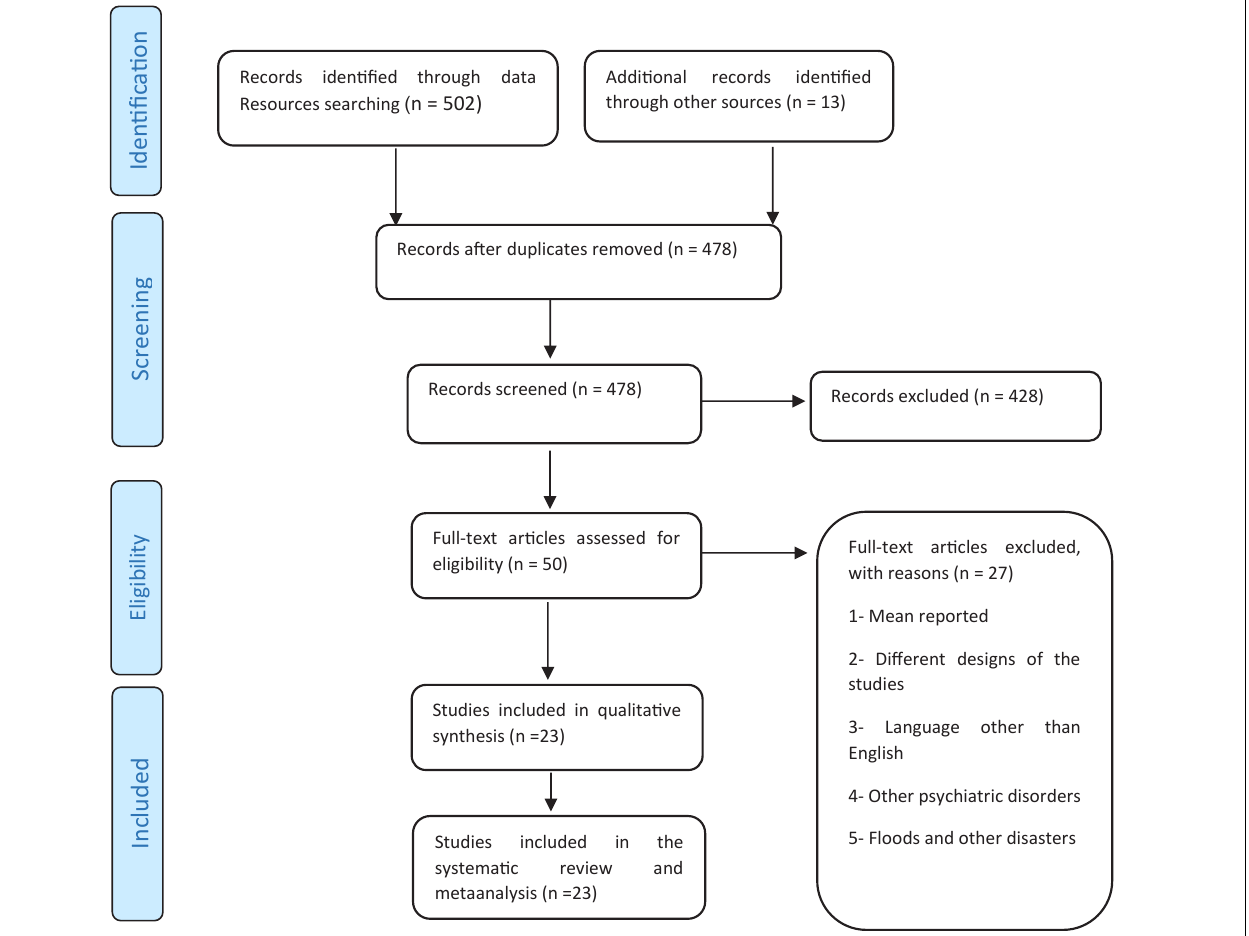
FIGURE 1 | Flowchart of the study and selection of studies based on PRISMA steps.